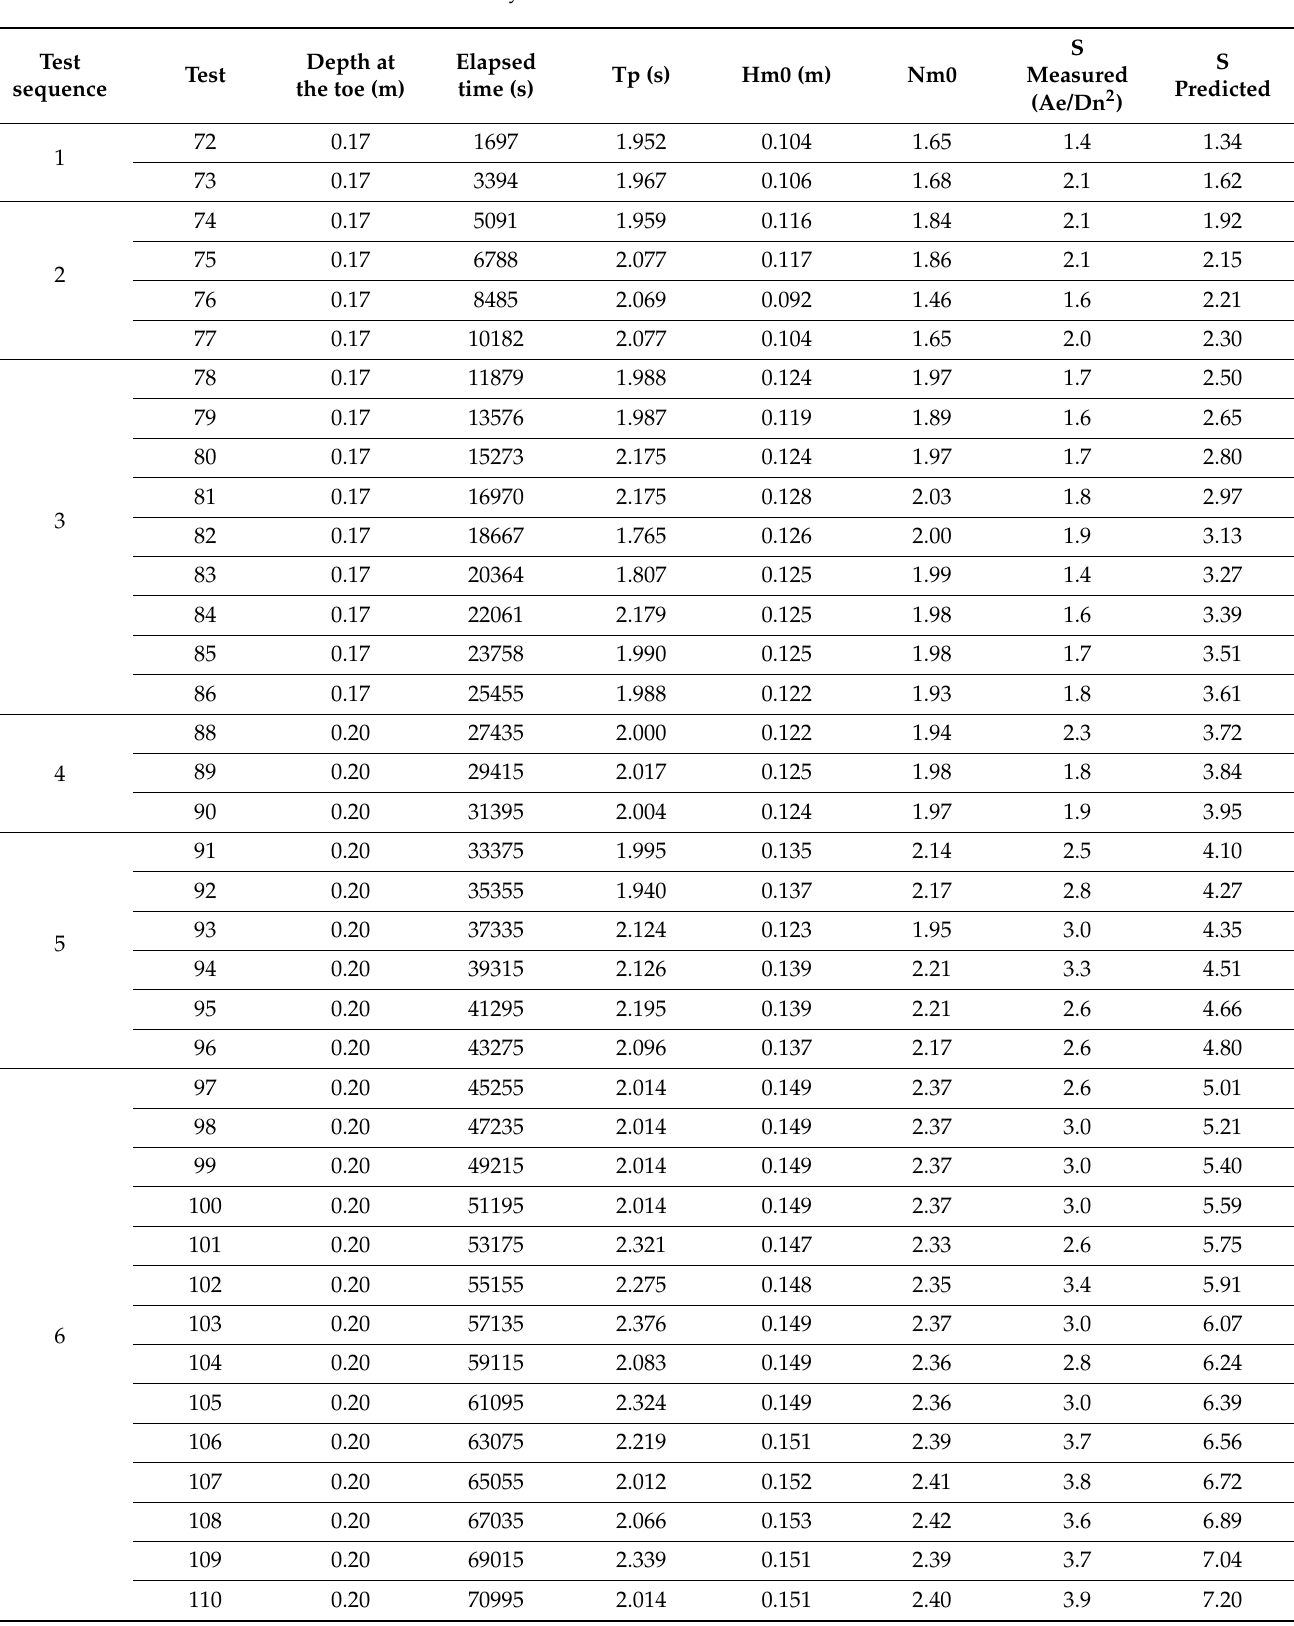
Table 4. Damage values (S) measured and predicted by Melby’s formula (Equation (6)) and coeffi- cients for armour layer made of